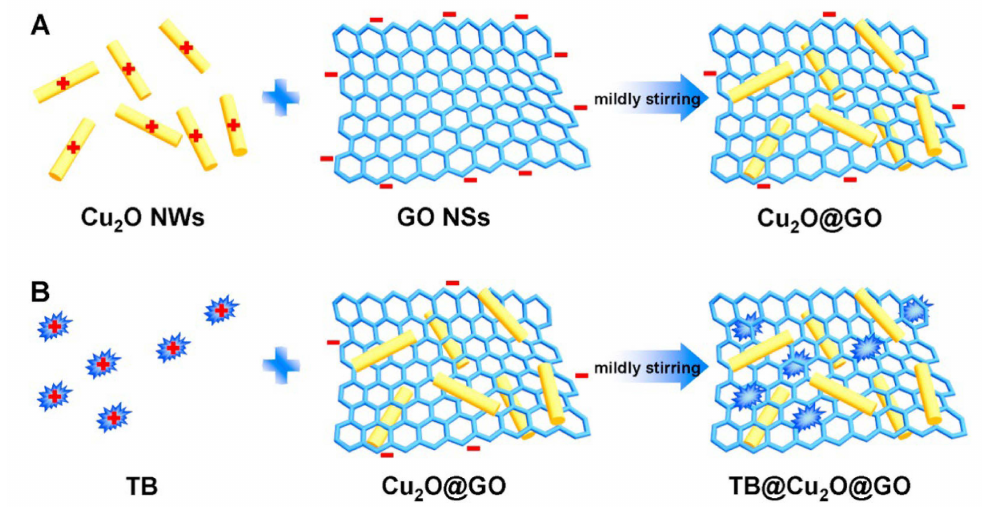
Figure 11. Two-step preparation (A and B) of TB@Cu 2 O@GO composite nanomaterial. Reprinted with permission from Ref. [99]. Copyright 2017,